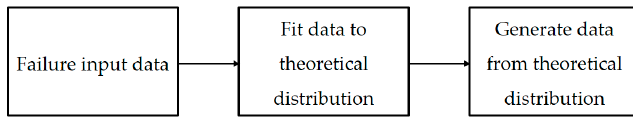
Figure 9. Procedure of processing failure input data [14].